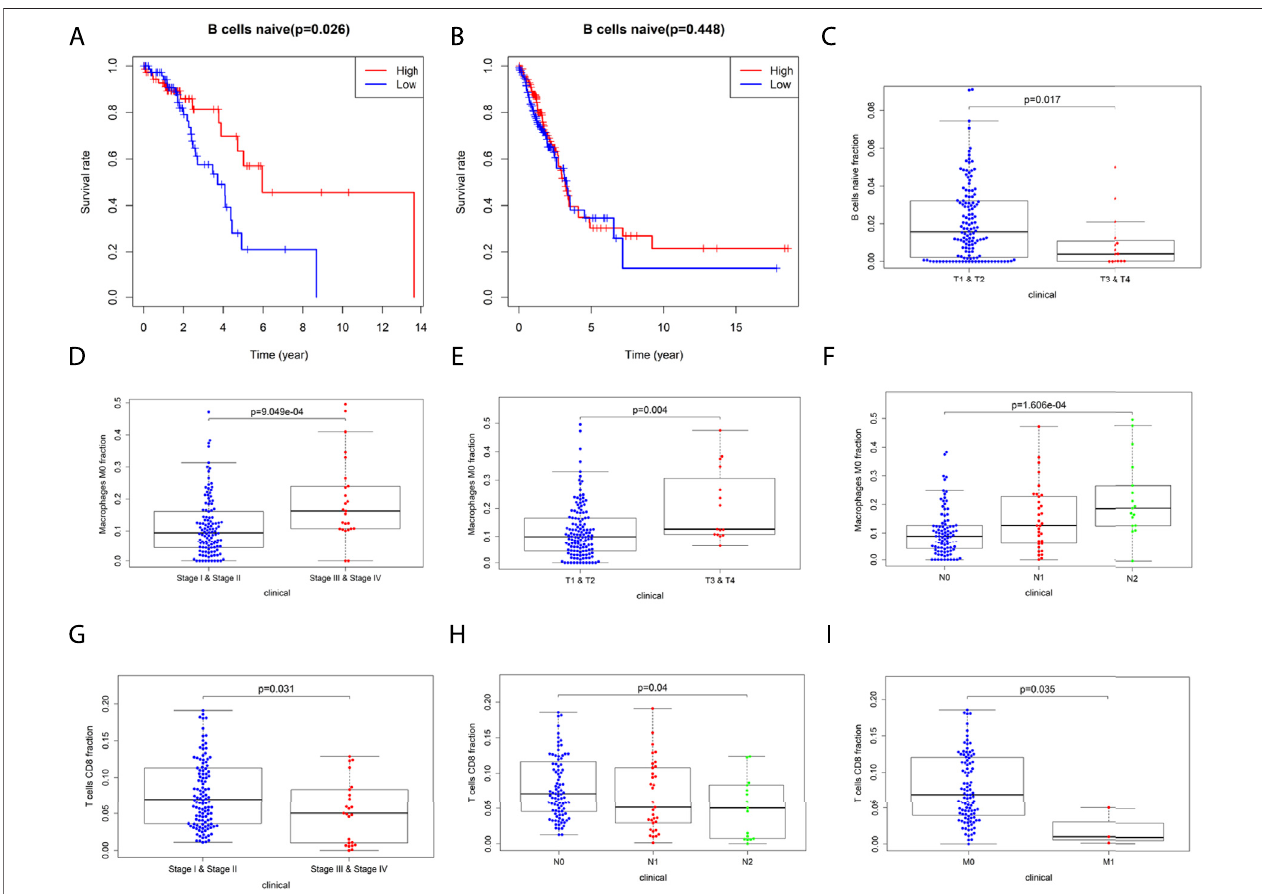
FIGURE 8 | (A-B) Correlation of naive B cells with overall survival in LUAD patients in the CCL17 high- (A) and low- (B) expression groups. (C-I) Correlation of 22 immune cells with the clinical stages (stage, TNM stage) of LUAD patients in the CCL17 high-expression group. (C) Correlation of naive B cells in fi ltration with clinical stages(stageT)ofLUADpatients. (D-F) CorrelationofM0macrophagein fi ltrationwithclinicalstages(stage,stageT,andN)ofLUADpatients. (G-I) CorrelationofTcells CD8 in fi ltration with clinical stages (stage, stage N, and M) of LUAD patients.